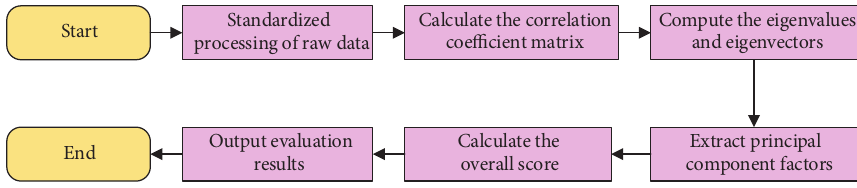
Figure 2: Structural flowchart of principal component analysis. Table 1: Summary of market share data of three major industries over the years (unit: %).